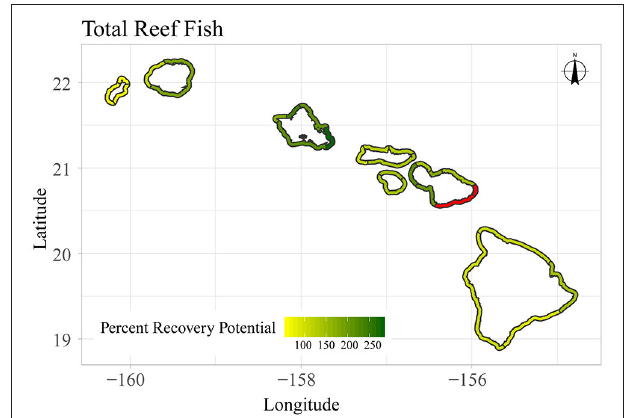
FIGURE 10 | Map of sector-level, mean percent recovery potential for total reef fish biomass in the main Hawaiian Islands. Sectors with limited data are shown in